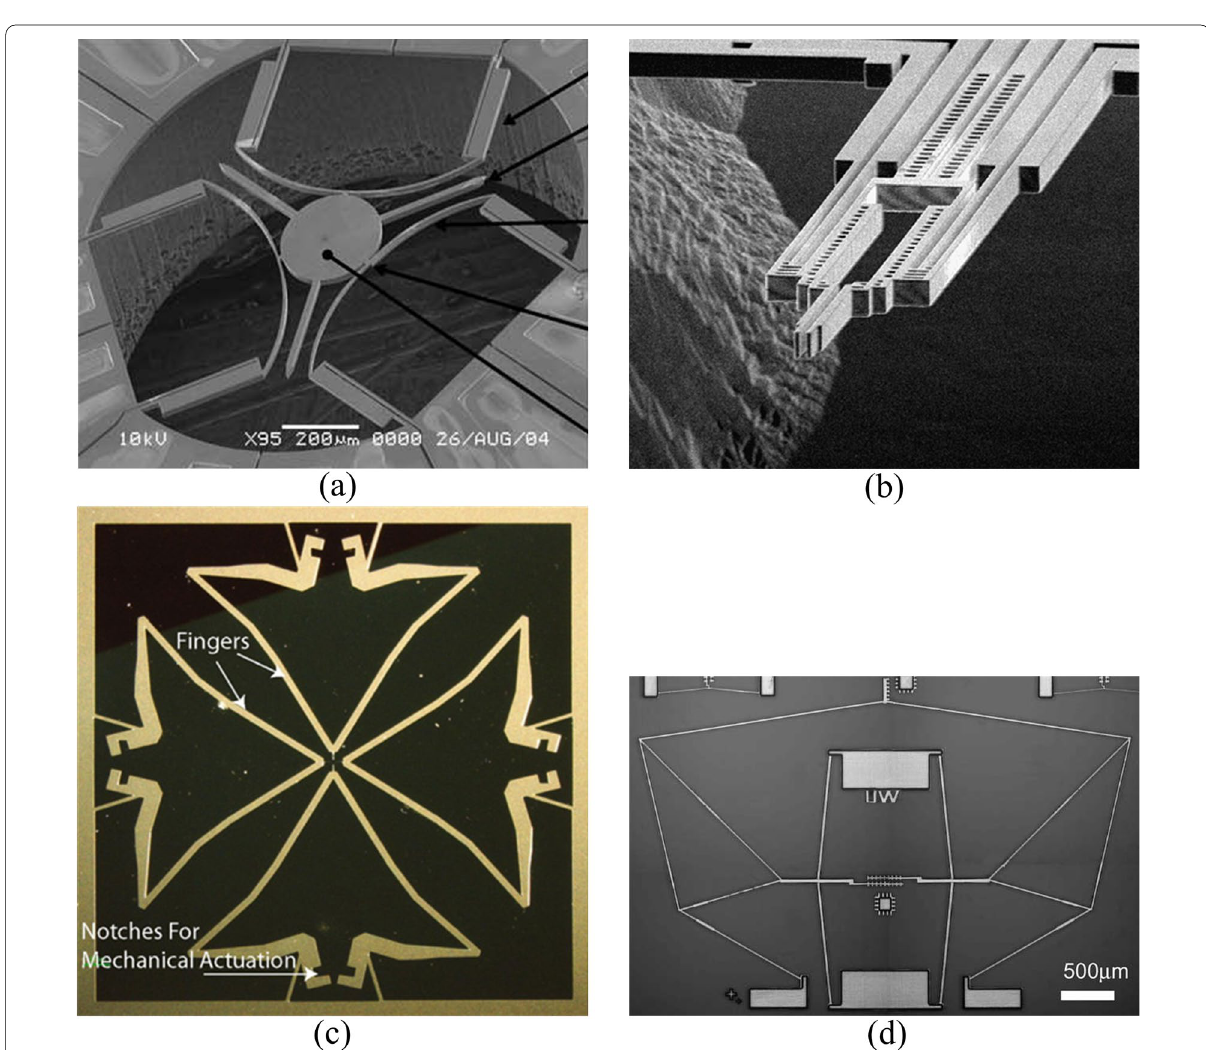
Figure 3 CMMs fabricated via bulk micromachining: ( a ) Nanopositioner by Chen and Culpepper [28] (©Elsevier. Adapted by permission of Elsevier. Permission to reuse must be obtained from the rightsholder), ( b ) Electrothermally actuated microgripper by Volland et al. [55] (©Elsevier. Adapted by permission of Elsevier. Permission to reuse must be obtained from the rightsholder), ( c ) Multi-fingered micromechanism for coordinated